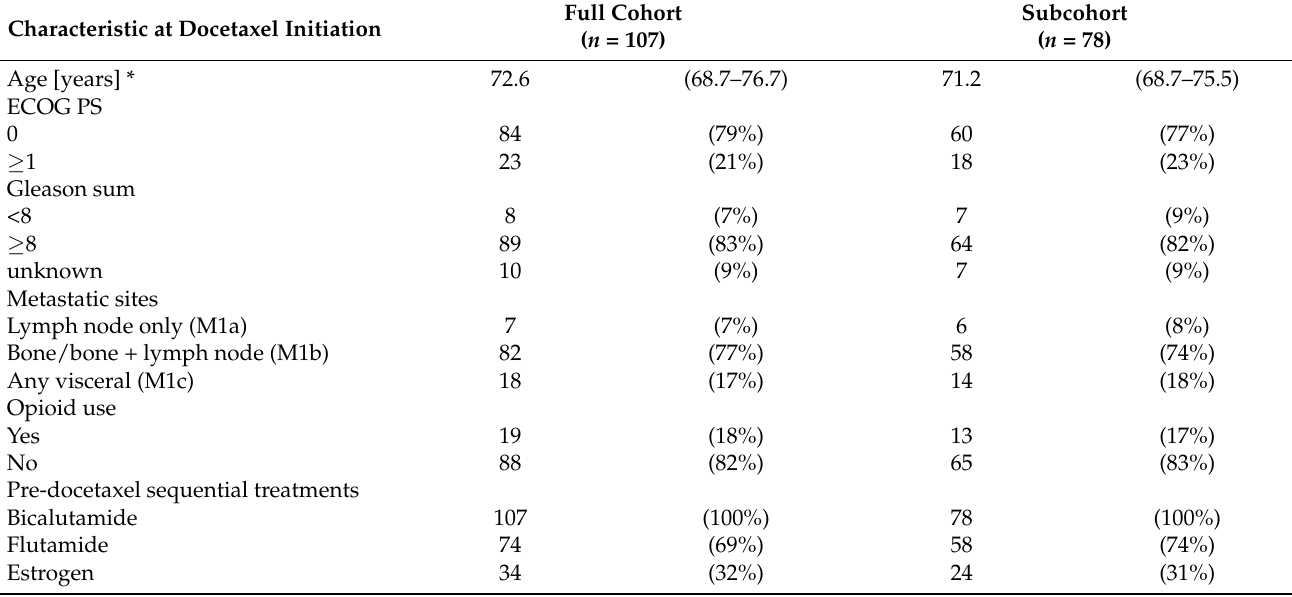
Table 1. Baseline characteristics of mCRPC men (subcohort: mCRPC men treated with four or more cycles of docetaxel). Characteristic at Docetaxel